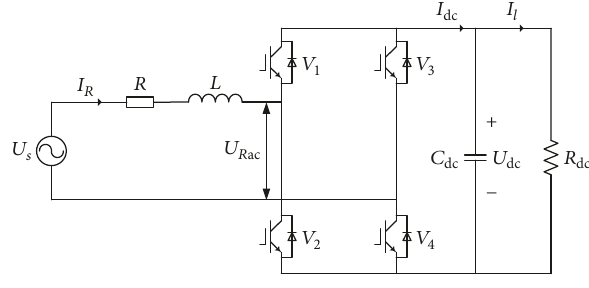
Figure 1: Topology of single-phase